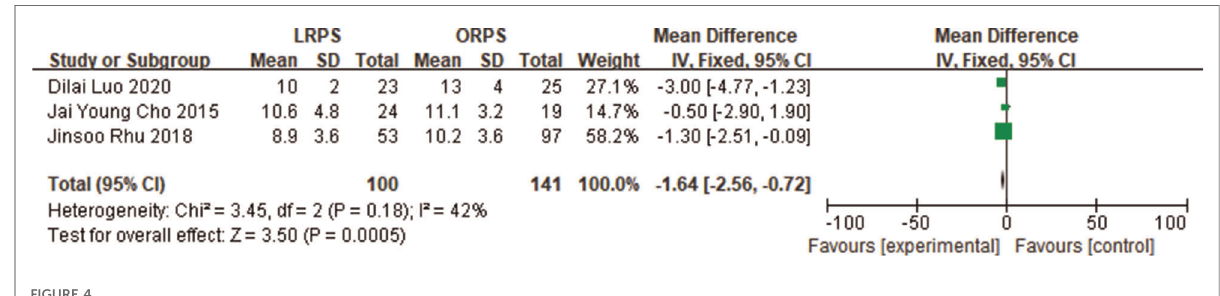
FIGURE 4 Pooled meta-analysis of hospital stay comparing LRPS with